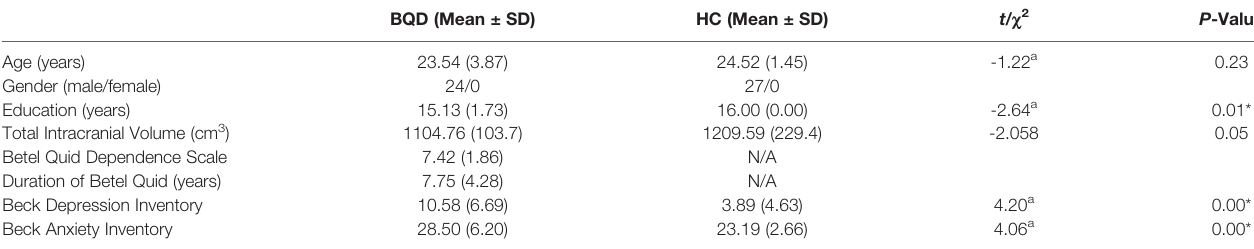
SD, standard deviation; N/A, not applicable; BQD, betel quid dependence; HC, healthy controls; a, independent-samples t-test; *P <